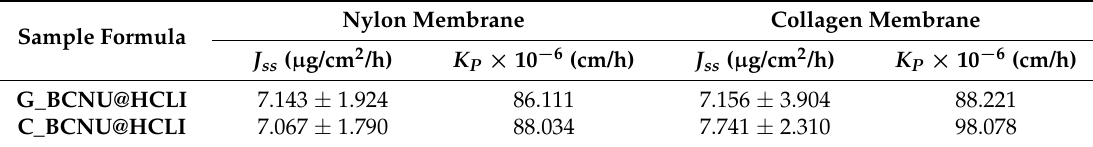
Table 3. Parameters specific to BCNU permeation in the semisolid dosage forms ( n = 3).